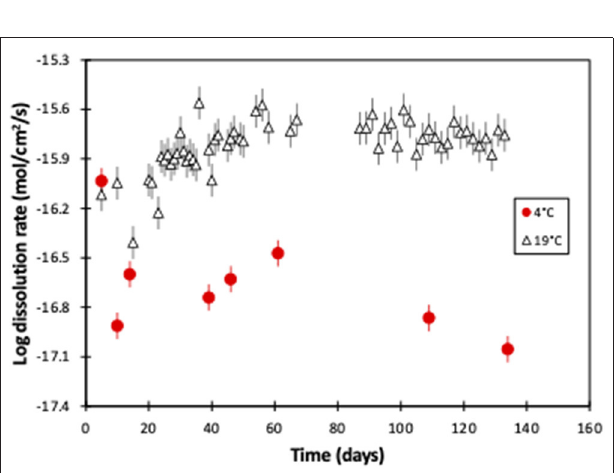
FIGURE 5 | Magnesium-derived olivine dissolution rates of this 4 ◦ C experiment, and the 19 ◦ C experiment (Renforth et al., 2015), as a function of experimental time. The error bars represent the compounded 2sd